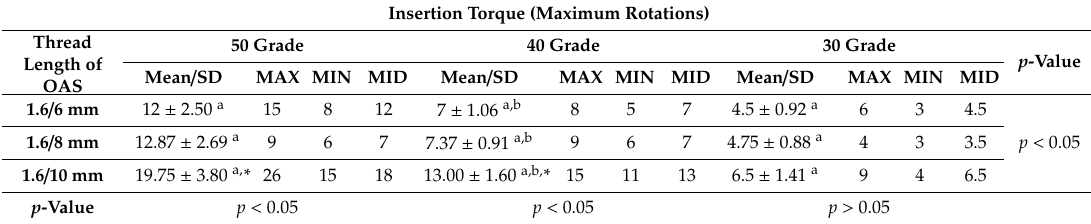
Table 2. Insertion torque values (maximum rotations) measured using the automatic device anchorage method.